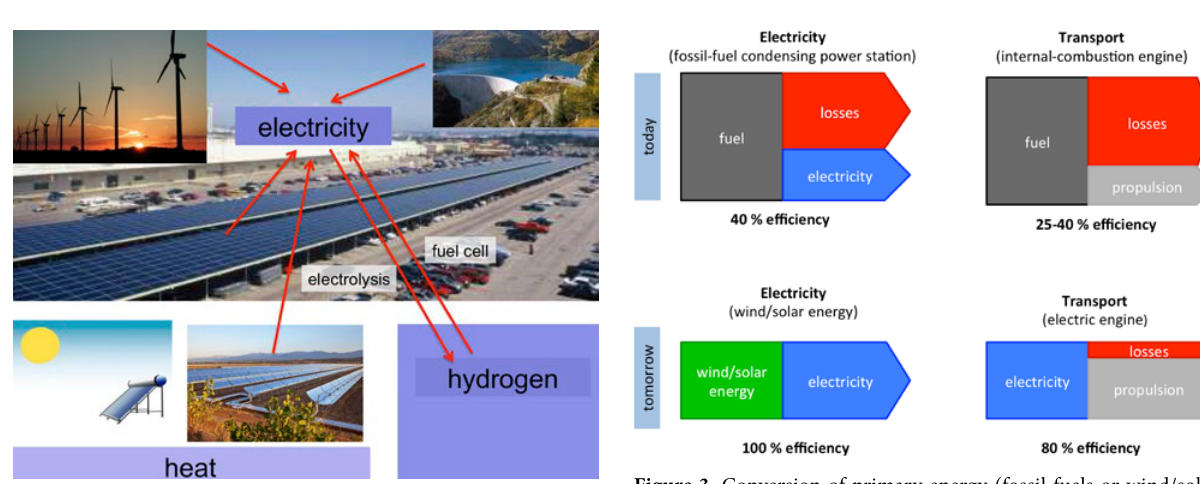
Figure 2. Renewable primary energies generate electricity.